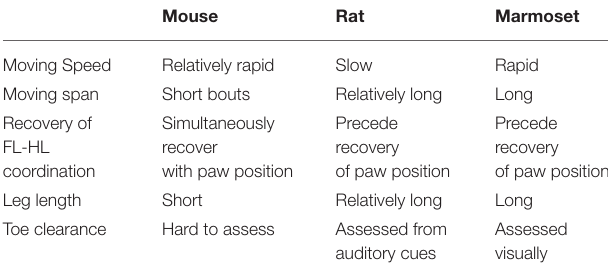
TABLE 1 | Characteristics of locomotion in the open